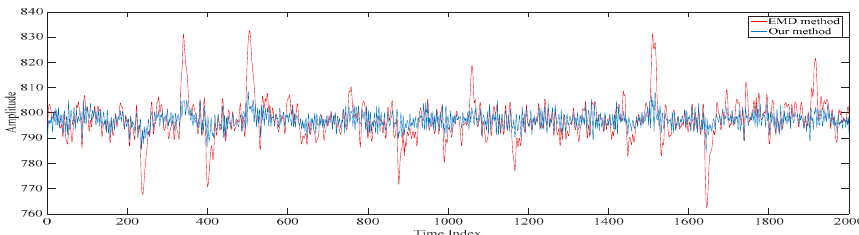
Figure 15. The despiked electroencephalograms obtained based on our proposed method and the conventional empirical mode decomposition-based method.